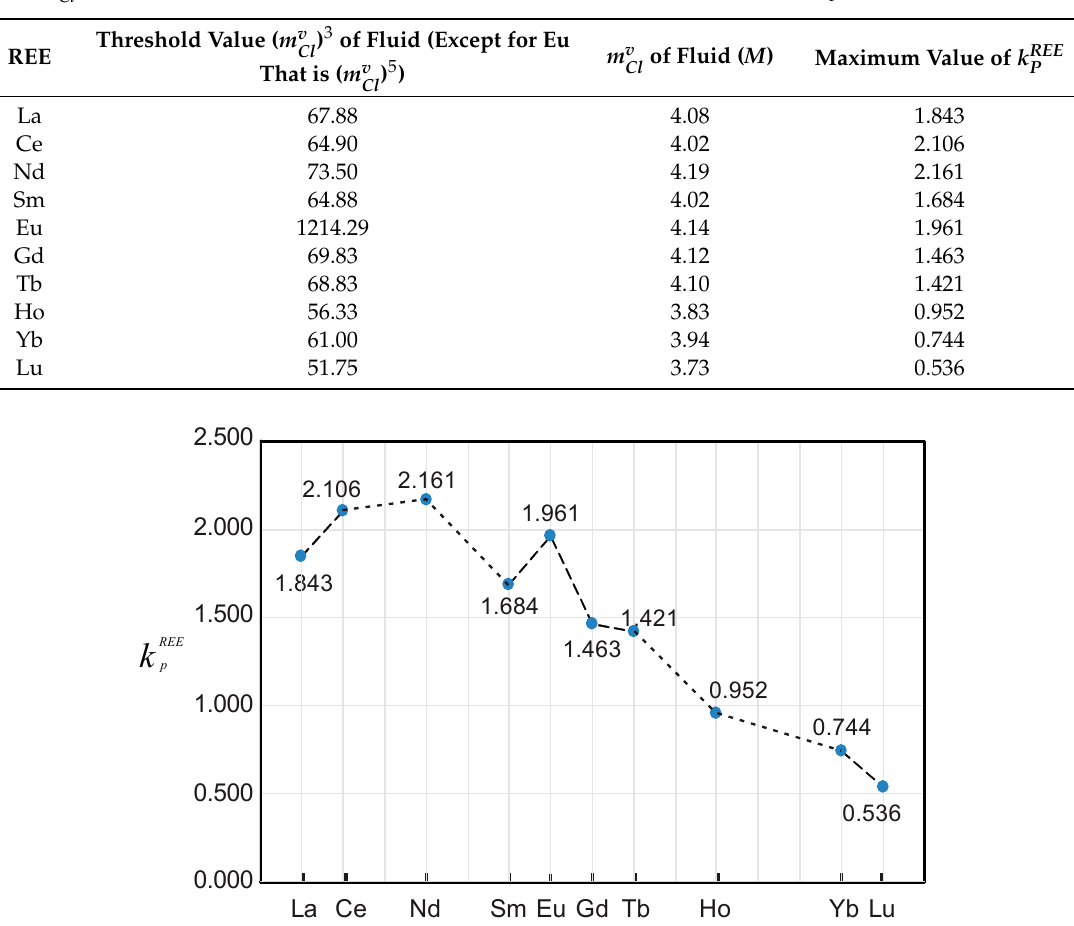
Figure 2. Plot of the predicted maximum values of REE partition coe ffi cients ( k REE ) between magmatic fluids and granitic melts based on the equations in Table 2. Number marked on the graph is the maximum value of predicted k REE for each element, e.g., La is equal to 1.843.